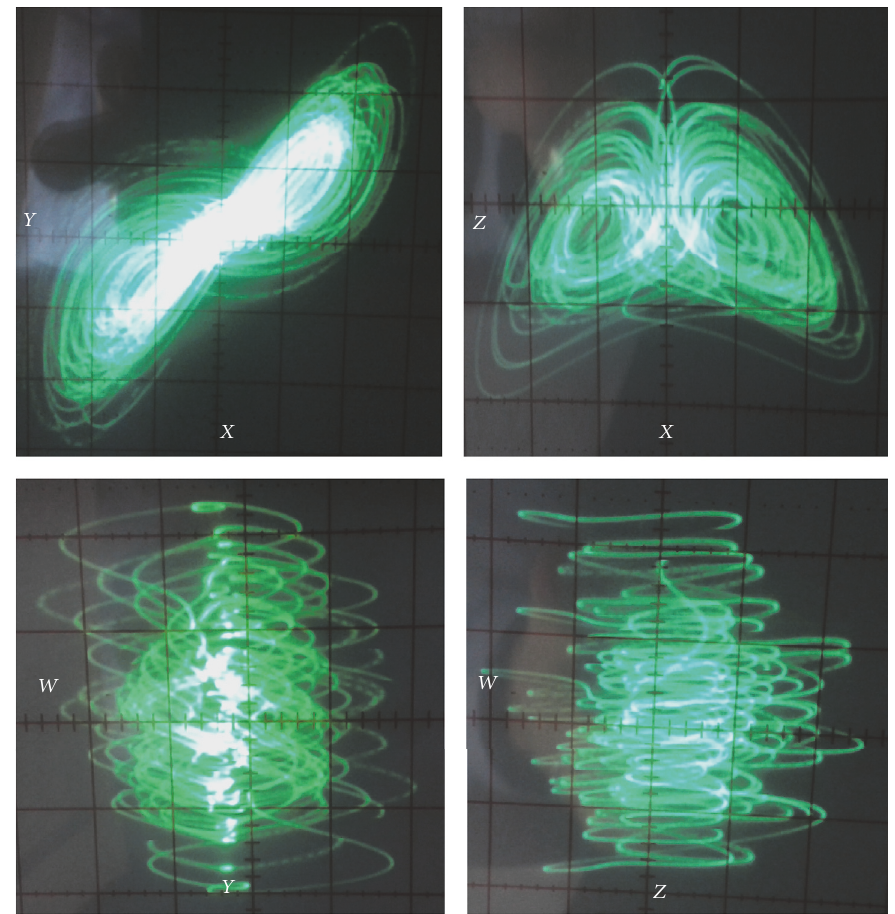
Figure 11: The phase portraits of scaled hyperchaotic system (17) with 𝑟 = 8 , 𝑚 = 0.5 , 𝑔 = 35 , and 𝑘 = 3 on the